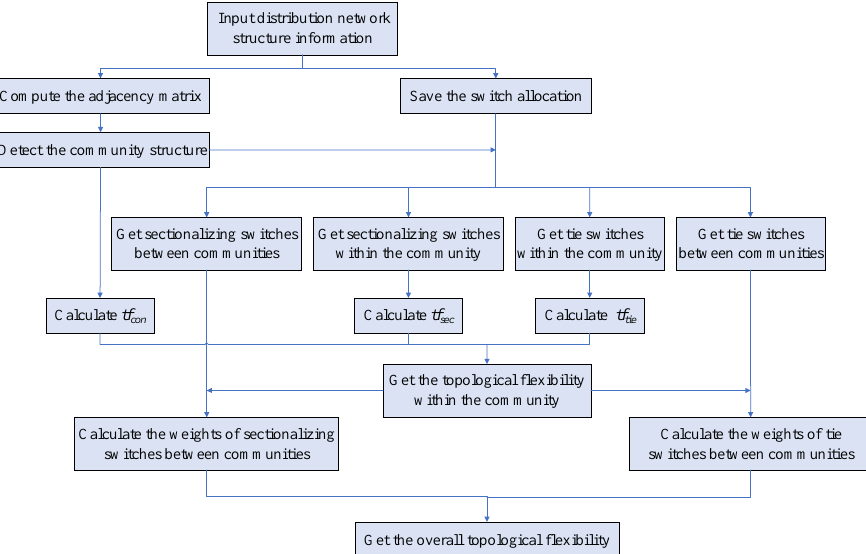
Figure 2. Flow chart to calculate the topological flexibility metric.